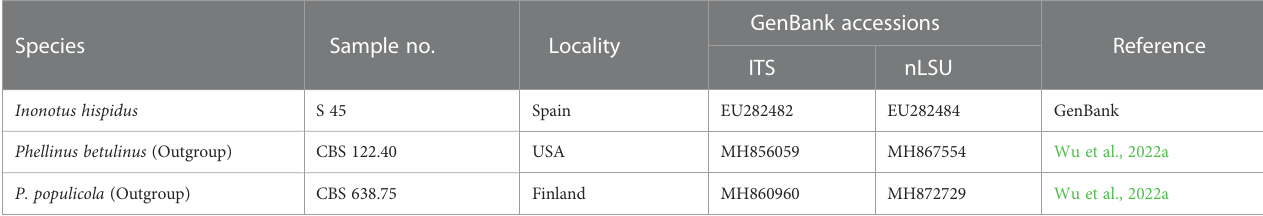
TABLE 2 Taxa, voucher specimens, and GenBank accession numbers of sequences used in the phylogeny of Pyrrhoderma .